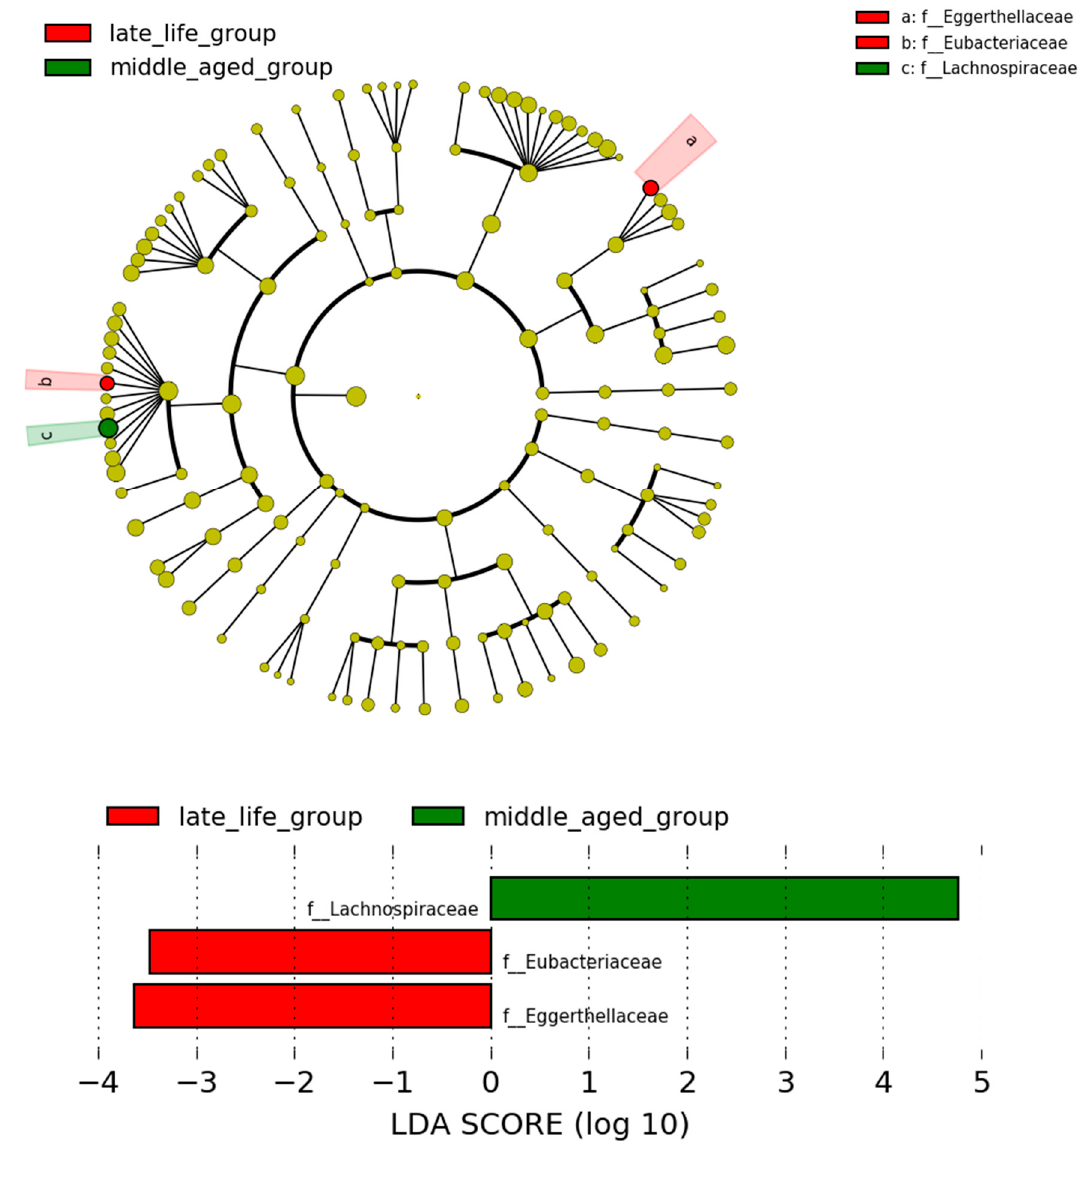
Figure 2. Specific bacterial contributor to the late-life (red) and middle-aged (green) groups by the LEfSe (Linear discriminant analysis (LDA) effect size) analysis at family level; Baseline ( a ), Endpoint ( b ). Only LDA thresholds of >3.0 as determined by LEfSe are shown. Notes: “f” = family level, “c” = class level, and “o” = order level.